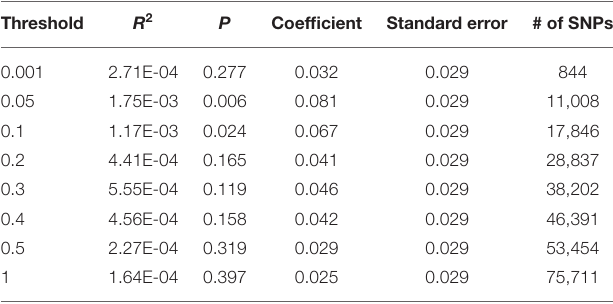
TABLE 2 | Insomnia